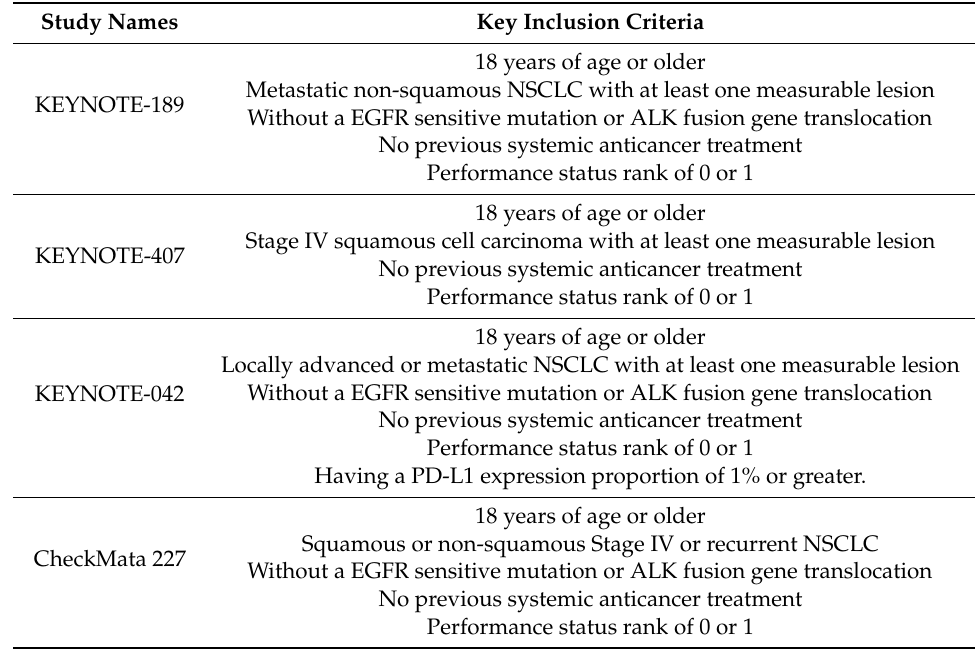
Figure 1. Flow diagram of the study selection process. RCT, randomized controlled trial.